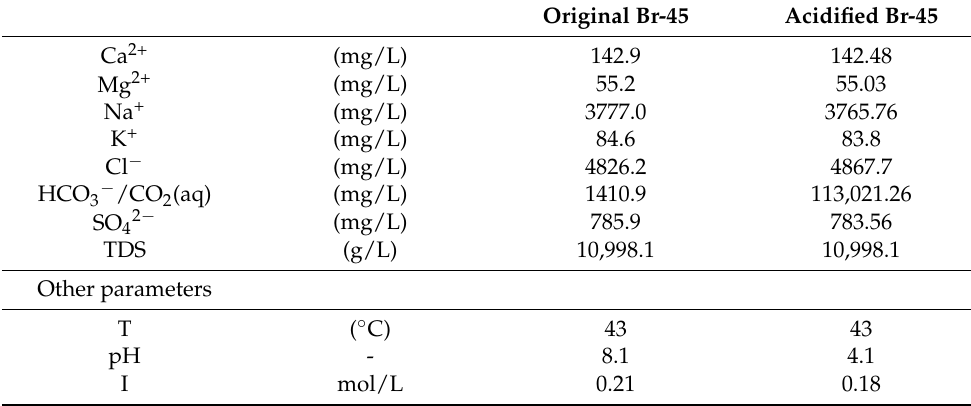
Table 6. Original and model-calculated acidification of Br-45 brackish